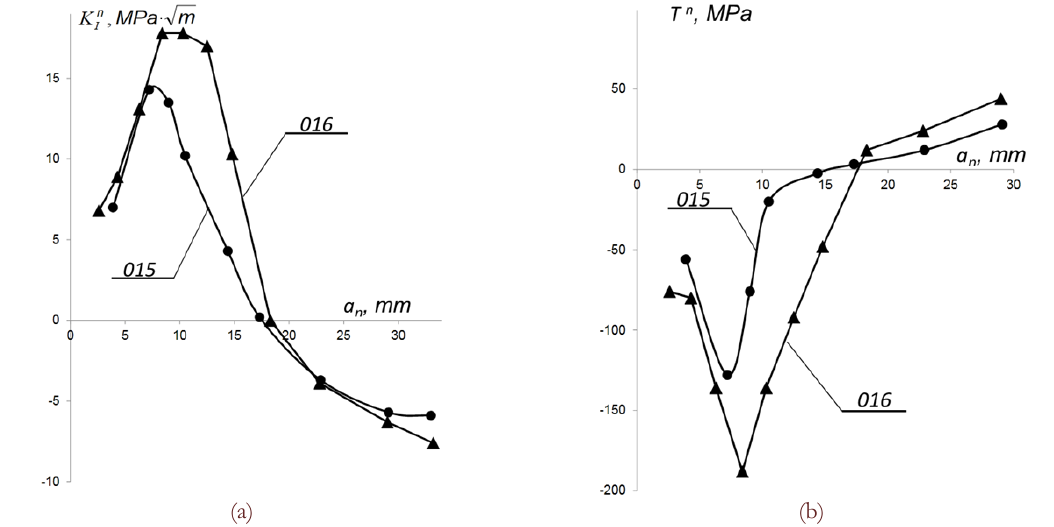
(a) and T-stress T (b) values form total notch I